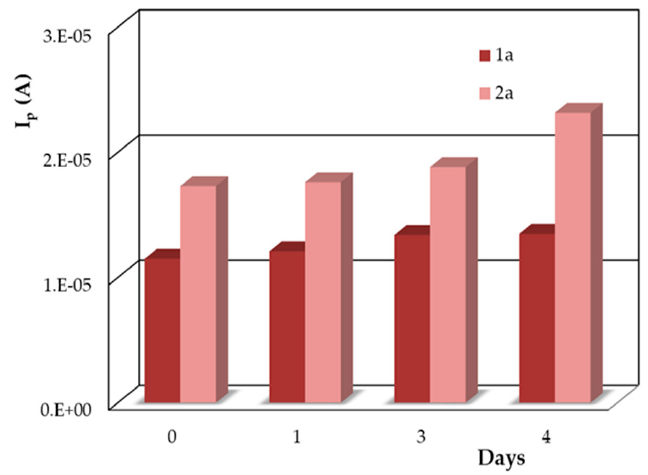
Figure 7. DPV anodic peak currents recorded on PGE_H for 1.00 × 10 − 5 mol/L DIO in 0.10 mol/L H 2 SO 4 obtained on different days from the same stock solution (1.00 × 10 − 3 mol/L DIO in 0.04 mol/L NaOH).